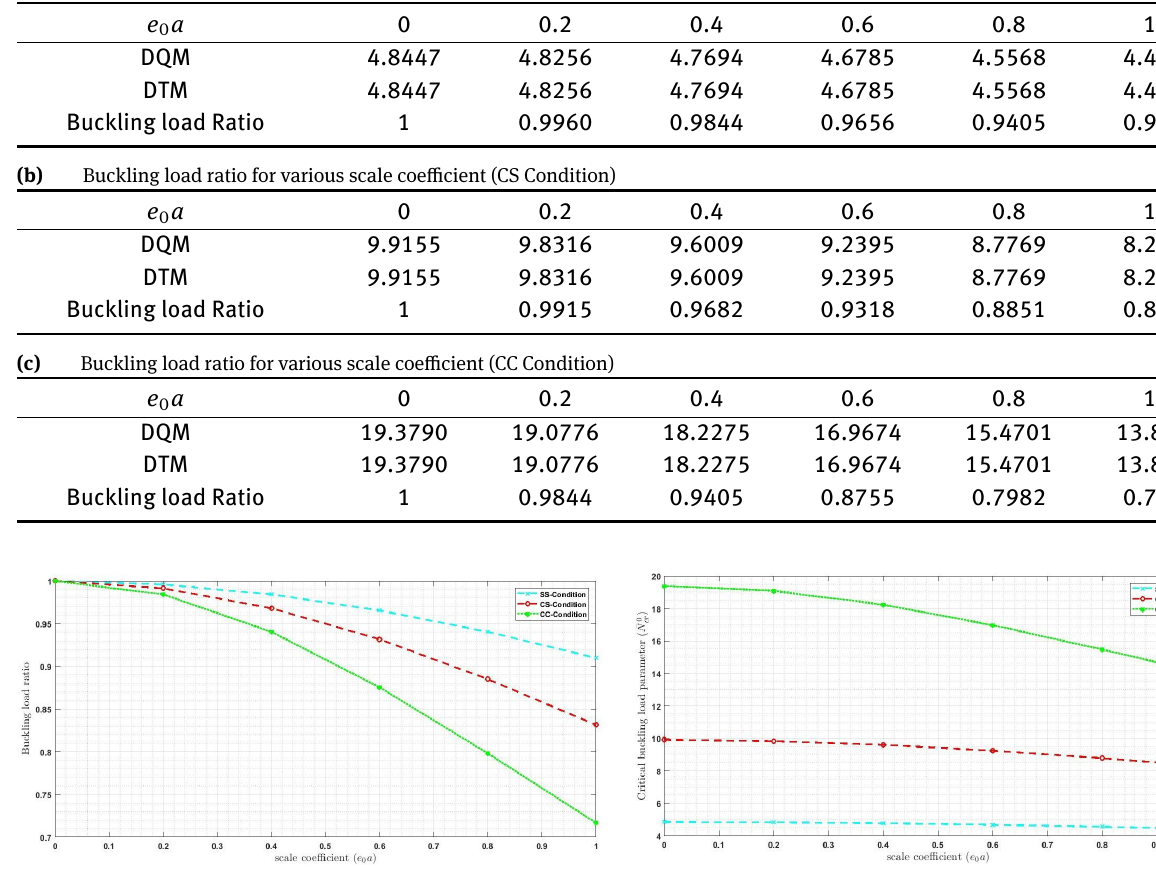
Figure 2: Buckling load ratio Vs. scale coeflcient ( e 0 a ) Figure 3: Critical buckling load parameter Vs. scale coeflcient for different B.C.s